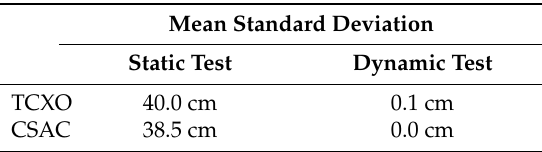
Figure 14. Available positions for: static test ( top ); and dynamic test ( bottom ). Table 9. Static and dynamic tests—planimetric error and mean standard deviation taking a single point as a reference in the static test and an external reference trajectory in the dynamic test.